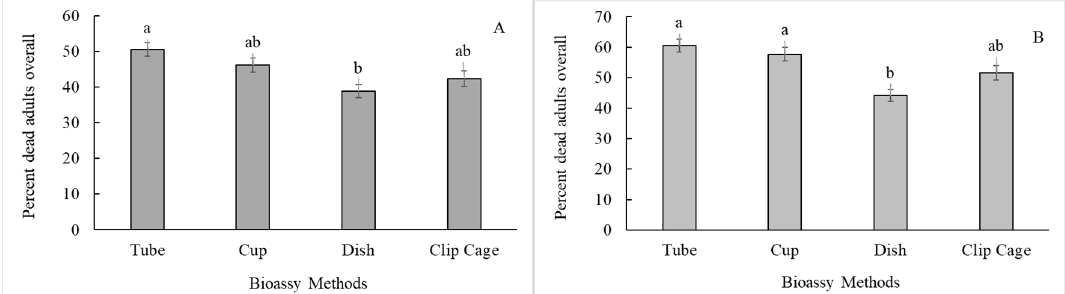
Figure 2. Percent adult mortality of the Florida ( A ) and Georgia ( B ) whitefly populations for tube, cup, petri dish, and clip cage bioassay methods. Bioassay means followed by the same lower case letter are not significantly different, Tukey’s test p < 0.05.